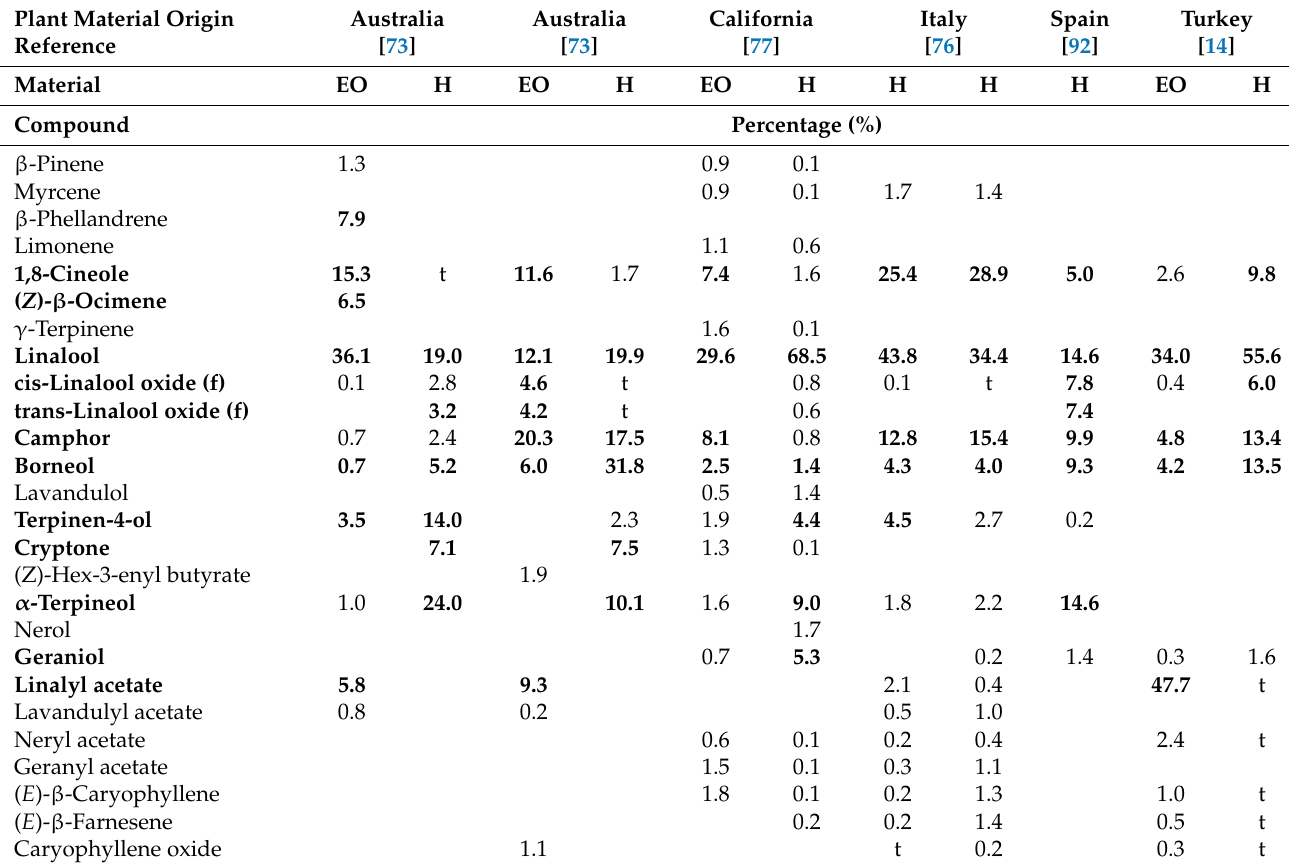
Table 9. Exemplary L. × intermedia hydrolate compositions (and their corresponding EOs) from different